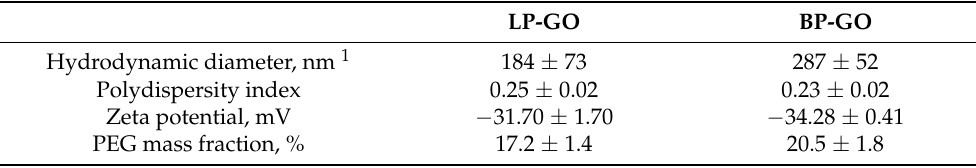
Table 1. Characteristics of the P-GO nanoparticles.